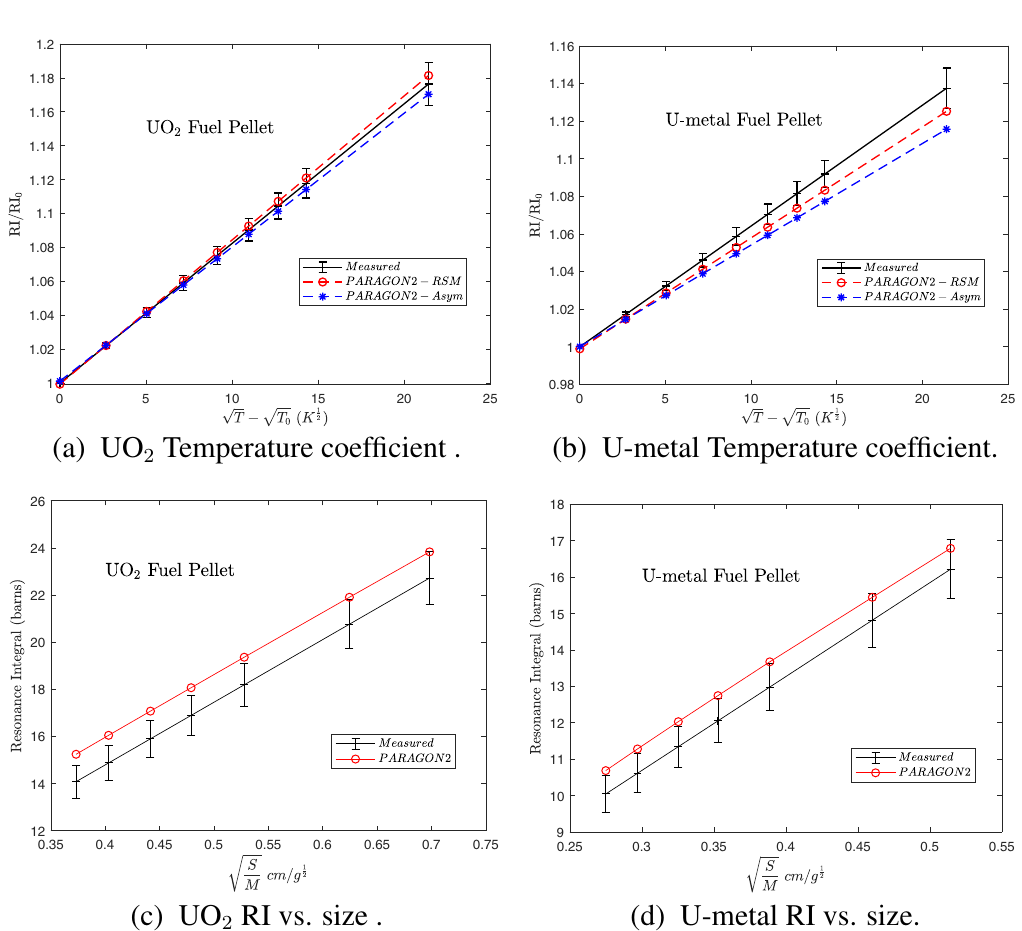
Figure 1: Hellstrand Experiment - U238 Resonance Integral vs. Temperature and Pellet Size.